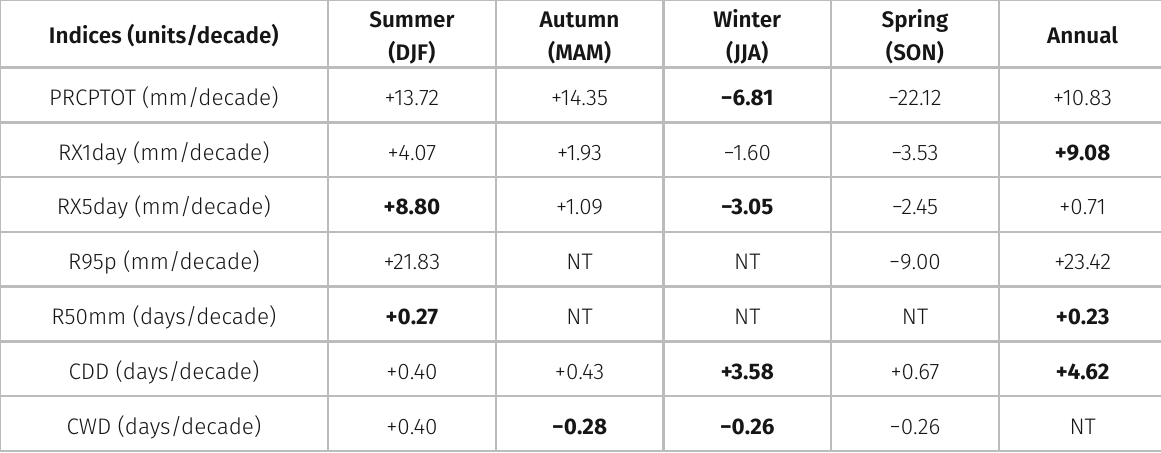
Table III. Seasonal and annual trends of precipitation indices from 1968 to 2017. Trends highlighted in bold were statistically significant at 95% significance level. Negative values indicate decreased trends, whereas positive values indicate increased trends. NT: No trend or values equal to